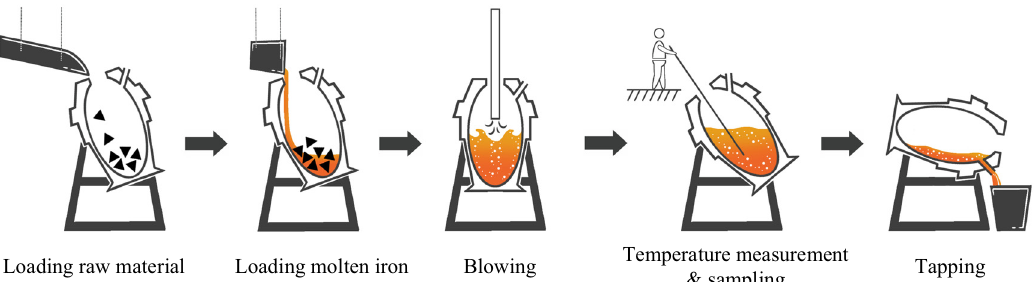
Figure 1: The process step of BOF